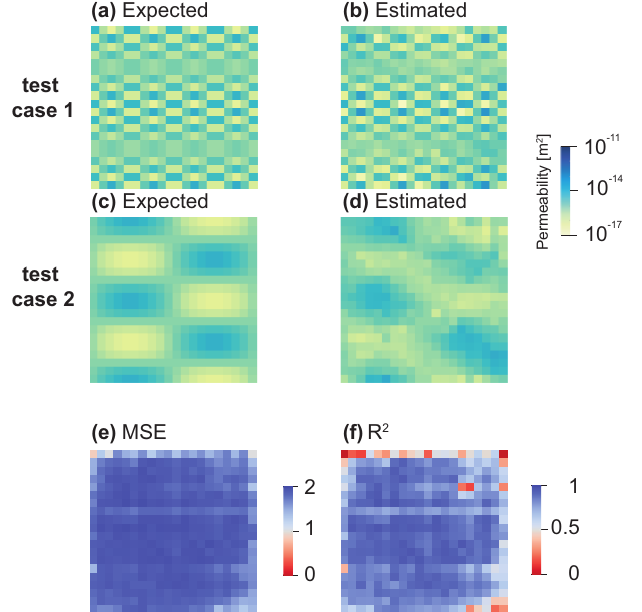
Figure 6. Results of permeability estimation for test dataset. Examples of ( a , c ) expected distribu- tions and ( b , d ) estimated results and spatial error distributions by ( e ) MSE and ( f ) coefficient of determination R 2